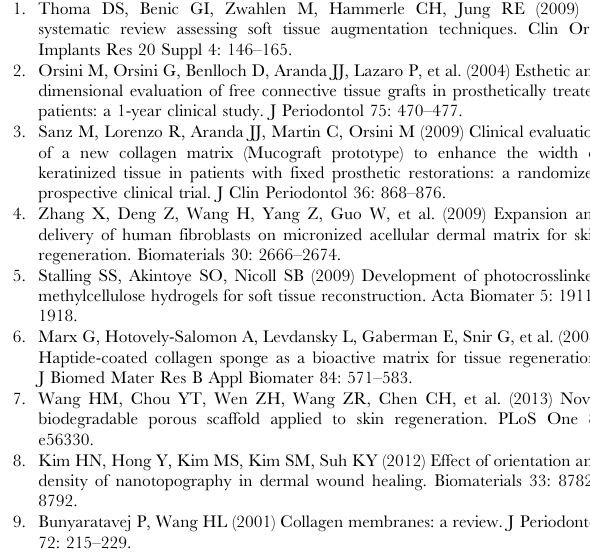
Table S1 Gene expression assays. Table S2 Corresponding data on cell numbers of human gingival fibroblasts in the gel type and the sponge type scaffolds. Table S2 shows the corresponding data of Figure 3. Table S3 Corresponding data on cell distance of human gingival fibroblasts in the gel type and sponge type scaffolds. Table S3 shows the corresponding data of figure 4.